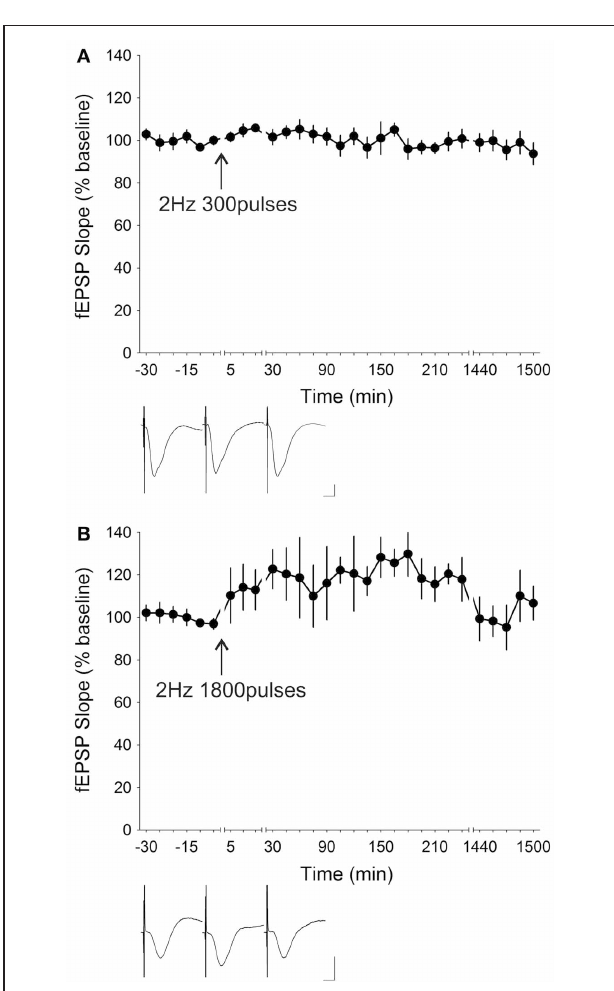
FIGURE 3 | Low-frequency stimulation at 2Hz did not induce synaptic depression but initiated slow-onset potentiation at higher number of stimuli. (A) Low-frequency stimulation (LFS) applied at 2Hz for 300 pulses did not result in a significant change (ANOVA, p = 0 . 42910) in synaptic efficacy at the CA1 synapses in freely behaving mice ( n = 8). (B) Increasing the number of stimuli to 1800 at 2Hz led to a significant slow-onset potentiation (ANOVA, p < 0 . 0001; n = 6). Insets: analog traces illustrating the Schaffer collateral–CA1 field potentials at pre-stimulation, 5min and 24h (1440min). Vertical scale bar corresponds to 2mV and horizontal scale bar corresponds to